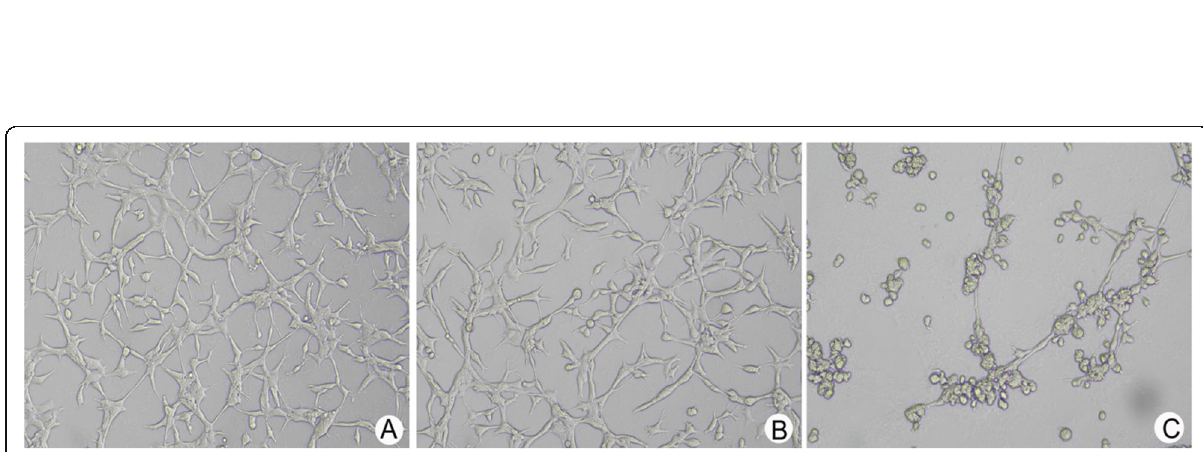
Fig. 7 Top panel: Three-dimensional cultures to quantify pipeline formation. Bottom panel: Quantitative data. ( a : control group; b : control SiRNA group; c : FoxM1 siRNA group) ** P <0.01 vs control